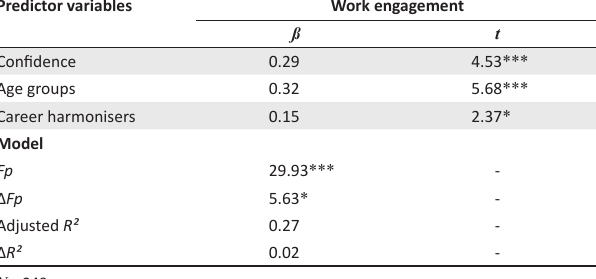
TABLE 2: Results of the stepwise regression analysis. Predictor variables